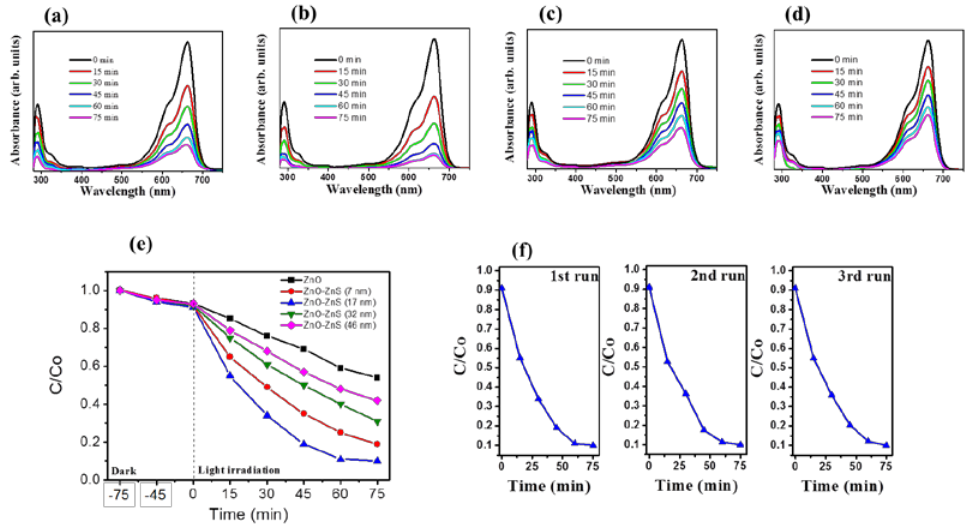
Figure 6. Intensity variation of absorbance spectra of MB solution vs. degradation duration containing various ZnO-ZnS nanorods with different sputtering ZnS thicknesses: ( a ) 7 nm. ( b ) 17 nm. ( c ) 32 nm. ( d ) 46 nm. ( e ) C/C o vs. irradiation time for MB solution containing various ZnO-ZnS nanorods in dark conditions and under solarlight illumination. For comparison those of pure ZnO nanorods are also shown in the plot. ( f ) Recycled photodegradation performances (three test runs) of MB solution containing the ZnO-ZnS (17 nm) nanorods.